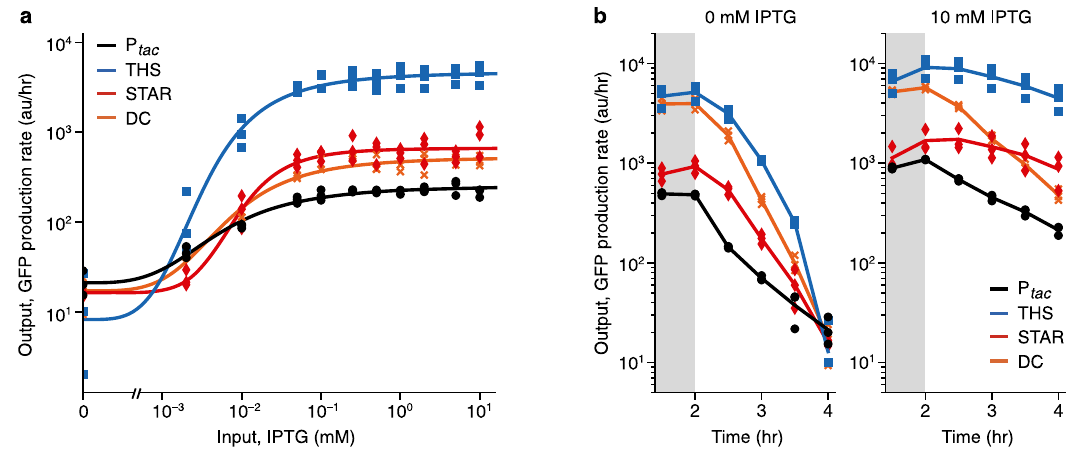
Fig. 5 Performance of single- and multi-level controllers in a cell-free expression system. a Response functions of the controllers showing output GFP production rates in arbitrary fl uorescence units per hour (arb. units/hr) at 4 hr after the start of the cell-free reaction for varying input IPTG concentrations (0, 0.002, 0.01, 0.05, 0.1, 0.25, 0.5, 1, 2, 5, 10 mM). Points show the three biological replicates for each controller and condition (black circles, P tac ; blue squares, THS; red diamonds, STAR; orange crosses, DC). b Output GFP production rate of the controllers over time since the start of the reaction. Time courses shown for controllers in an ‘ off ’ (0 mM IPTG; left) and ‘ on ’ (10 mM IPTG; right) state. GFP production rates at each time point calculated as an average GFP production rate over the previous 1.5 hr (Methods). Shaded region shows time period over which no regulation is observed. Source data are provided as a Source Data fi